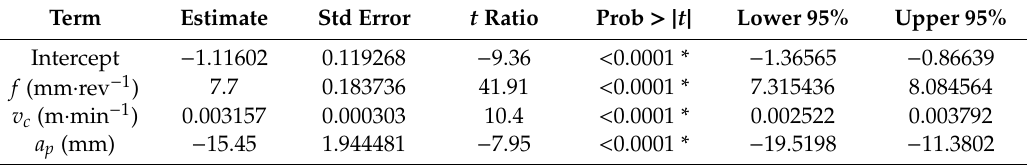
Table 7. Parameter estimates of the investigated dependence for the variable Ra